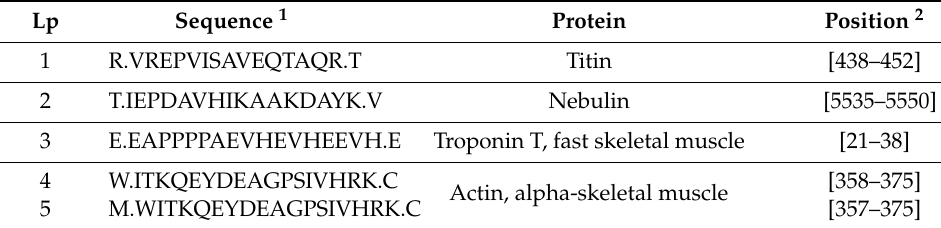
Table 1. Peptide sequences identified in all analyzed